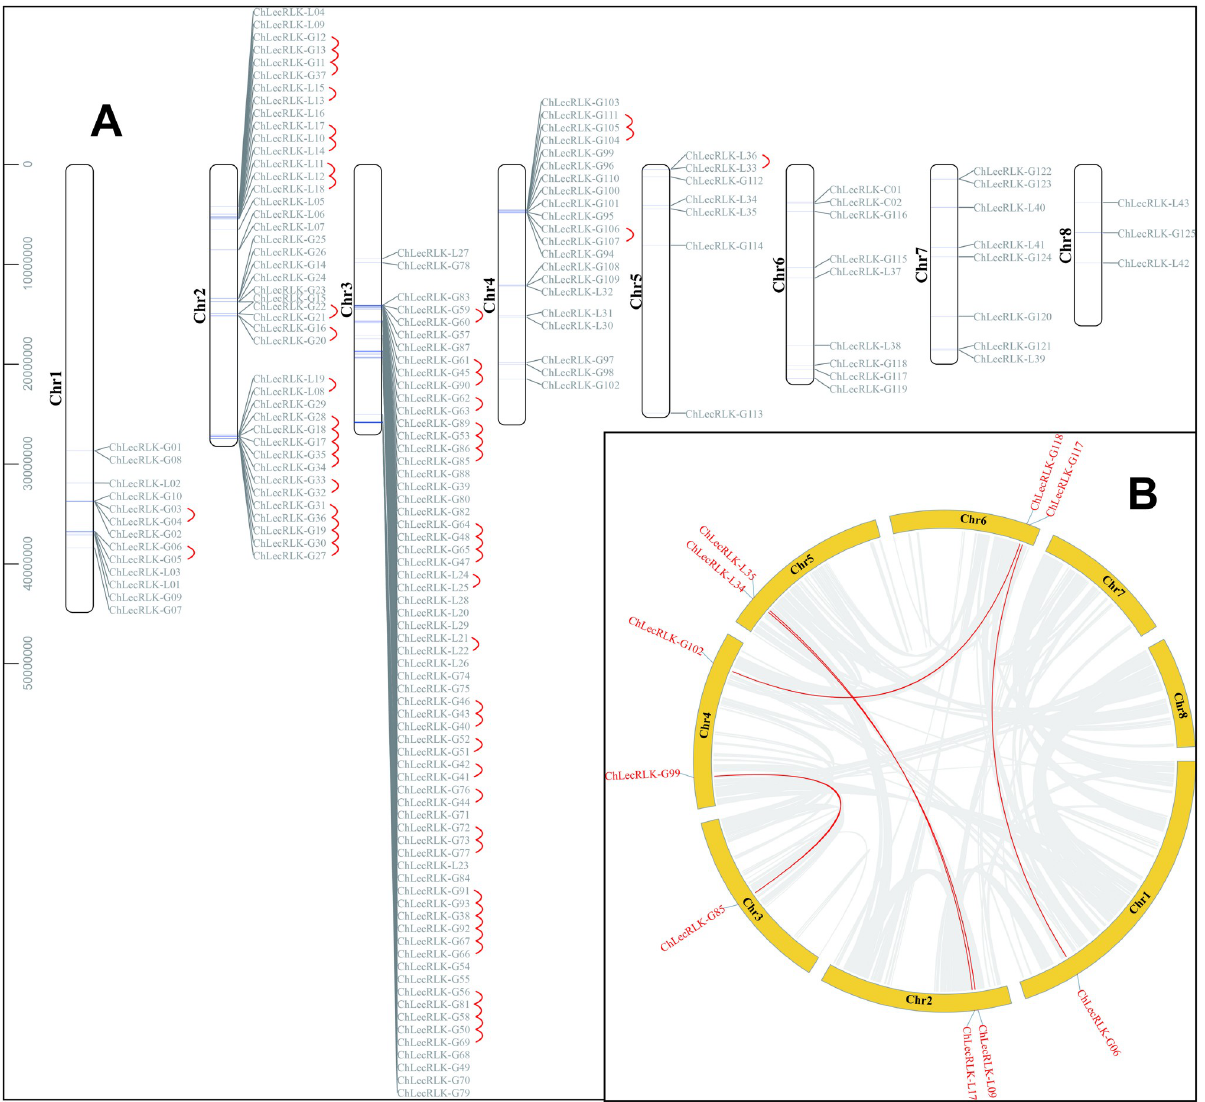
Fig 3. Distribution (A) and synteny (B) of LecRLKs genes on eight chromosomes of C . humilis . Tandem duplicated genes were marked with red curves. Chromosomal distances were given in base pairs. WGD/segmental duplicated genes were marked in red